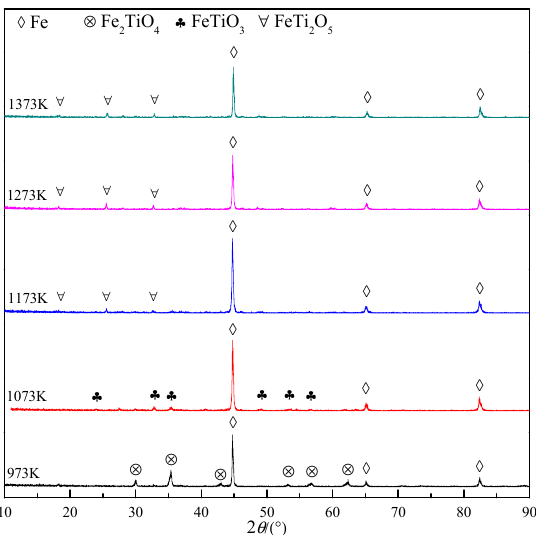
Figure 4. XRD patterns of the reduction products at 973 K–1373 K in H 2 /(H 2 + CO) = 1/2 atmosphere.